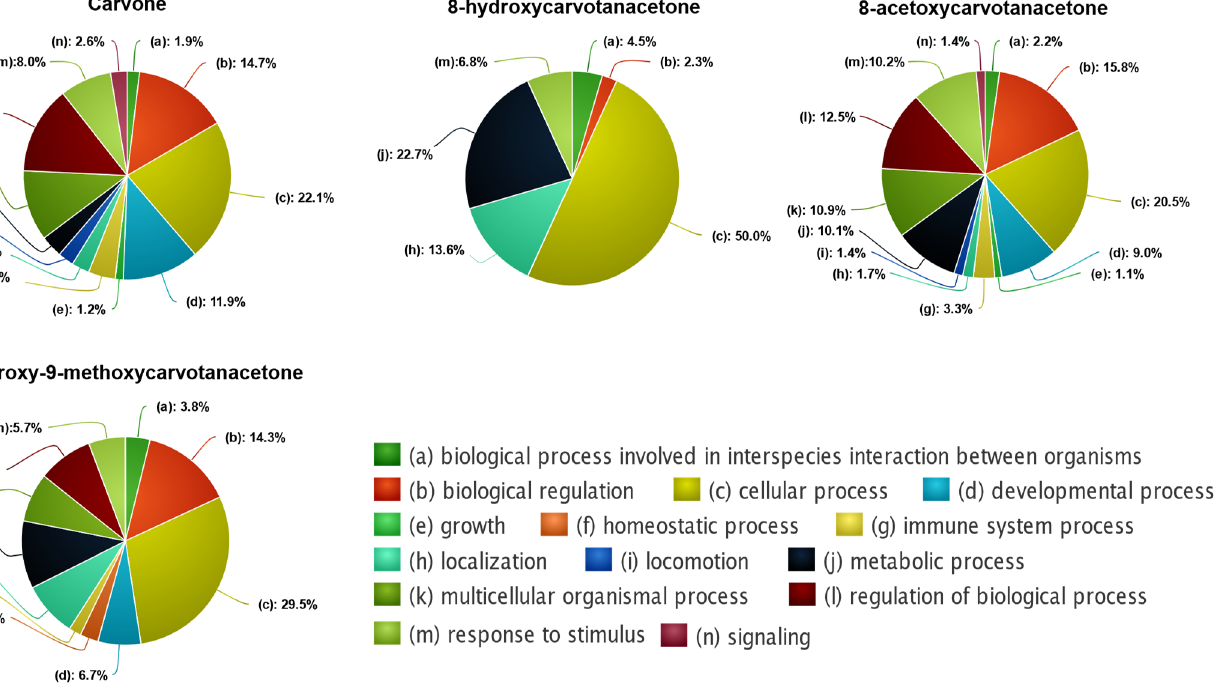
Figure 6. Functional enrichment analysis of cellular processes predicted to be affected by the 4 struc ‐ tures tested, according to DTI prediction model.